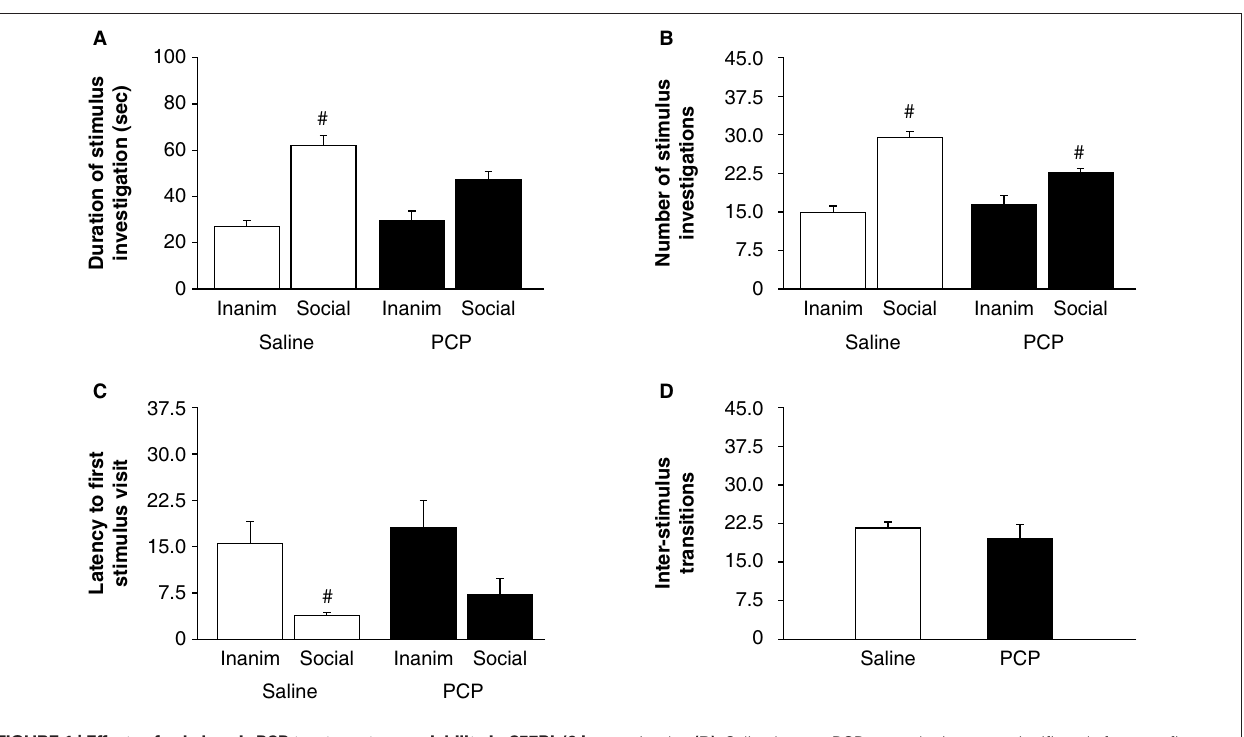
stimulus (B) . Saline but not PCP-treated mice were signifi cantly faster to fi rst investigate the social stimulus than the inanimate stimulus (C) . Treatment did not affect the number of transitions between stimuli (D) . Inamin = inanimate stimulus. Data are mean ± SEM. n = 7–8 per treatment. # p < 0.05 vs. inanimate/ same treatment